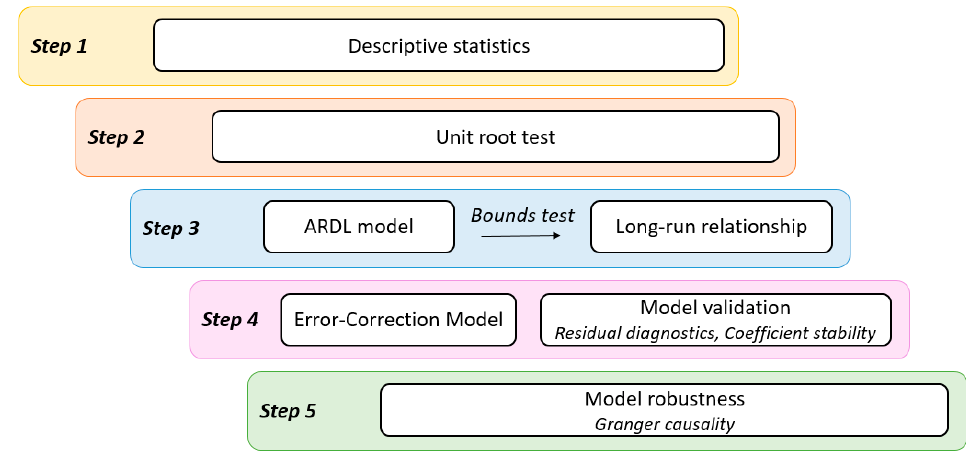
Figure 2. Empirical research methodology. Source: authors’ contribution.